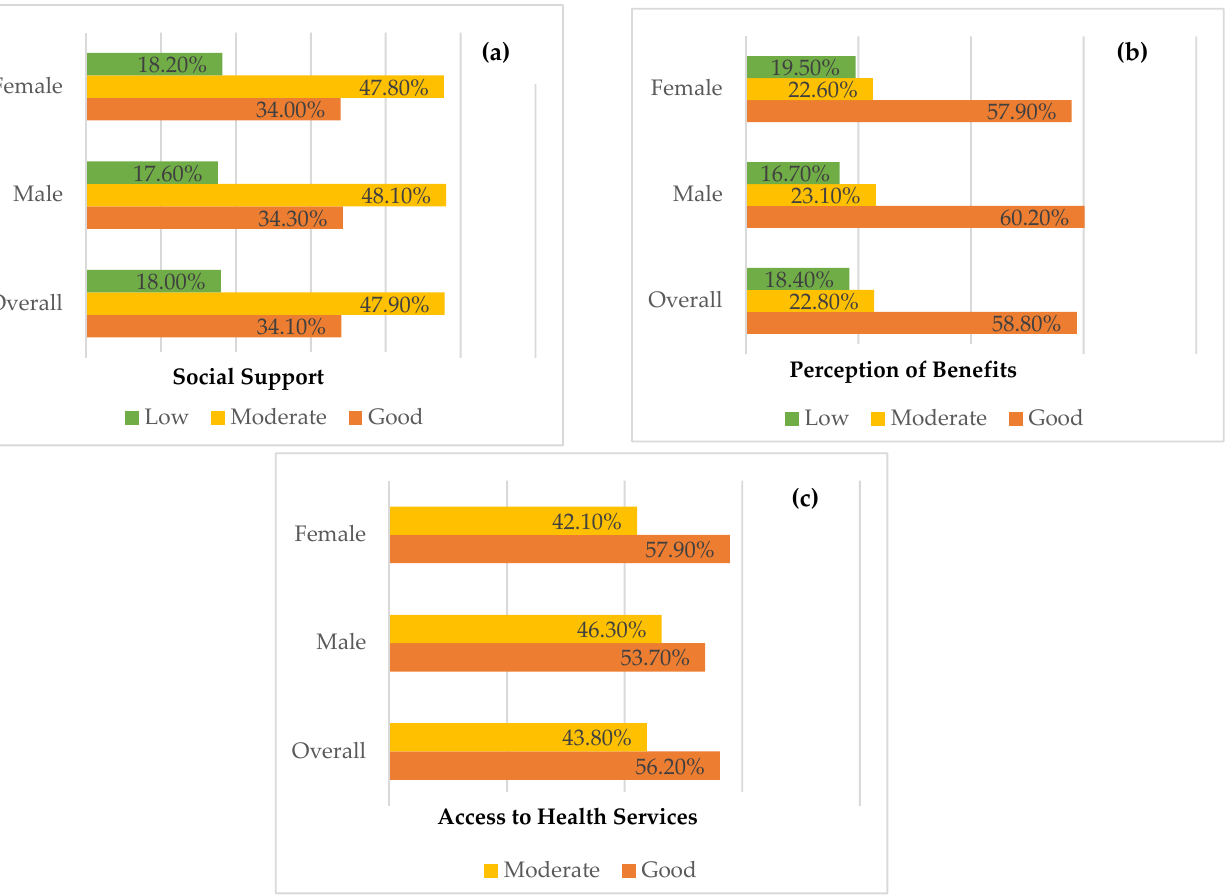
Figure 1. Participant levels of ( a ) social support; ( b ) perception of benefits; and ( c ) access to health services. Table 2. Factors associated with access to health